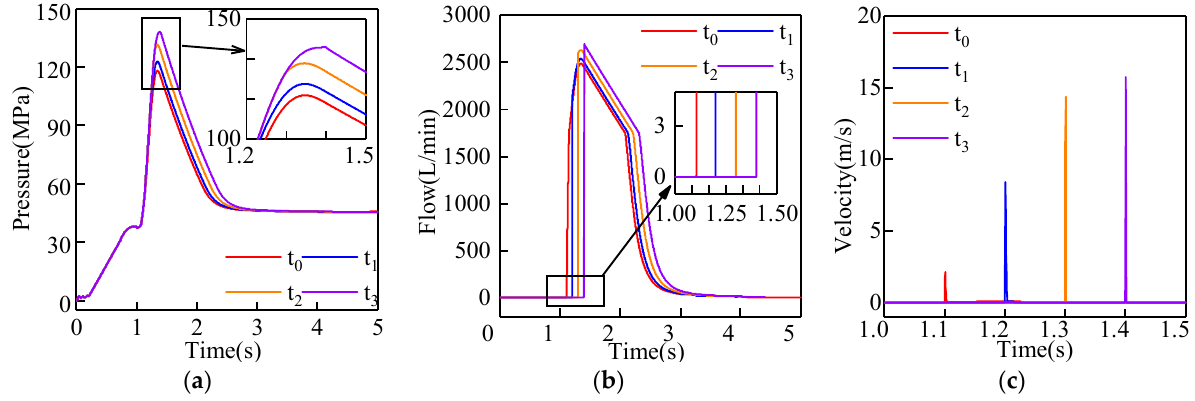
Figure 14. ( a ) Pressure of the lower chamber of the column at different delay times. ( b ) Flow of the lower chamber of the column at different delay times. ( c ) Velocity of the relief valve spool.